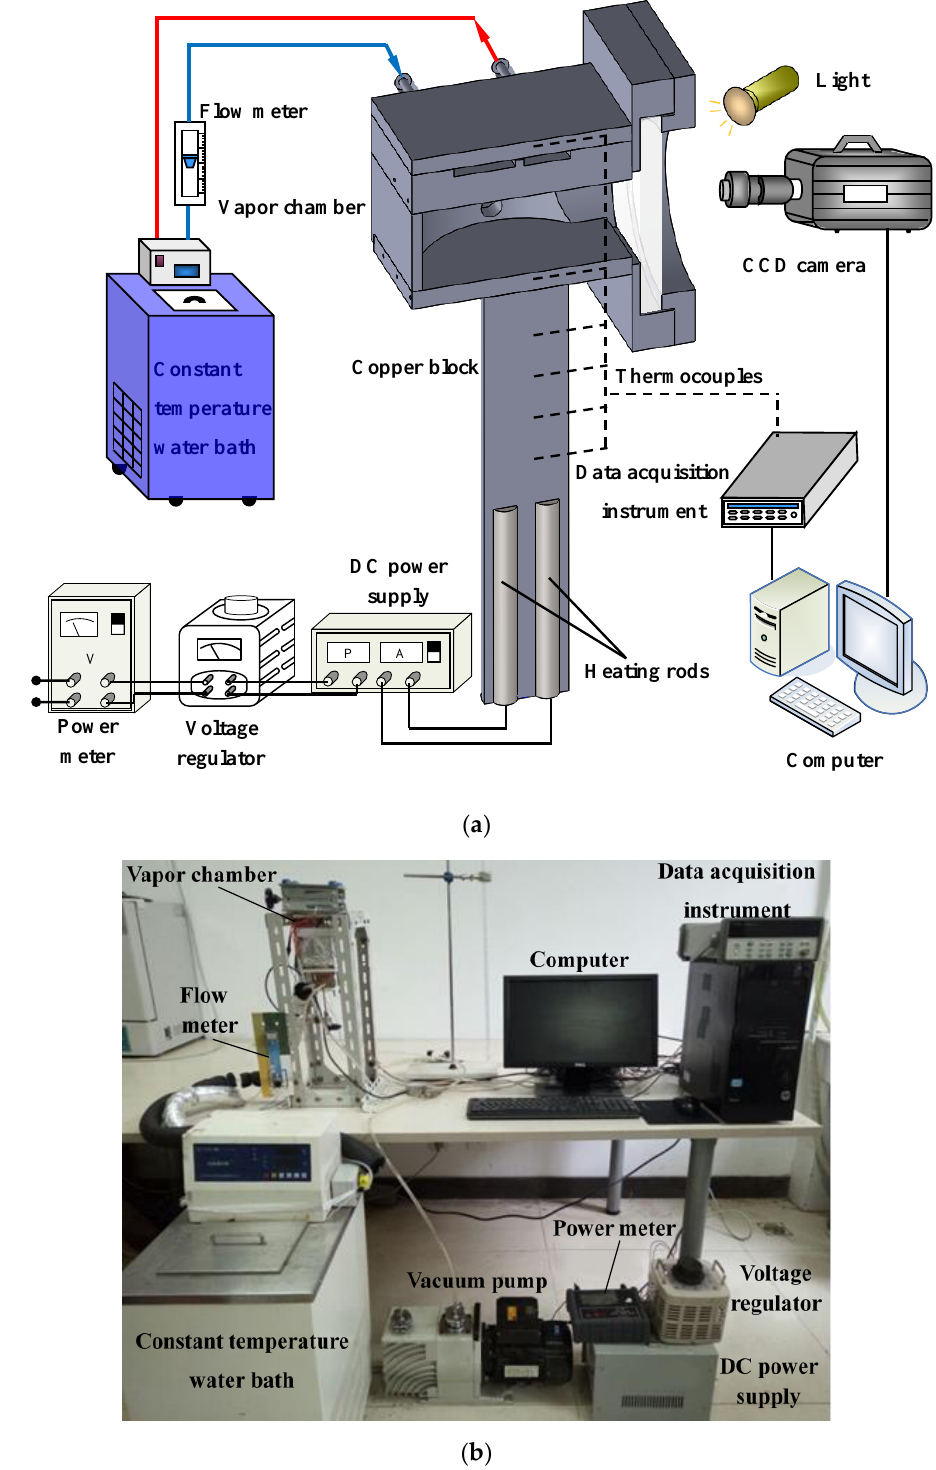
Figure 1. ( a ) Schematic diagram of the experimental set and ( b ) the experimental rig.